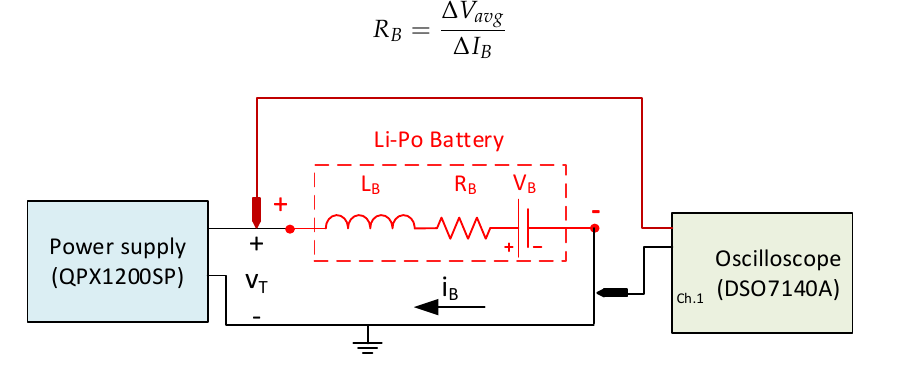
Figure 2. Experimental set-up to measure the battery series-resistance.